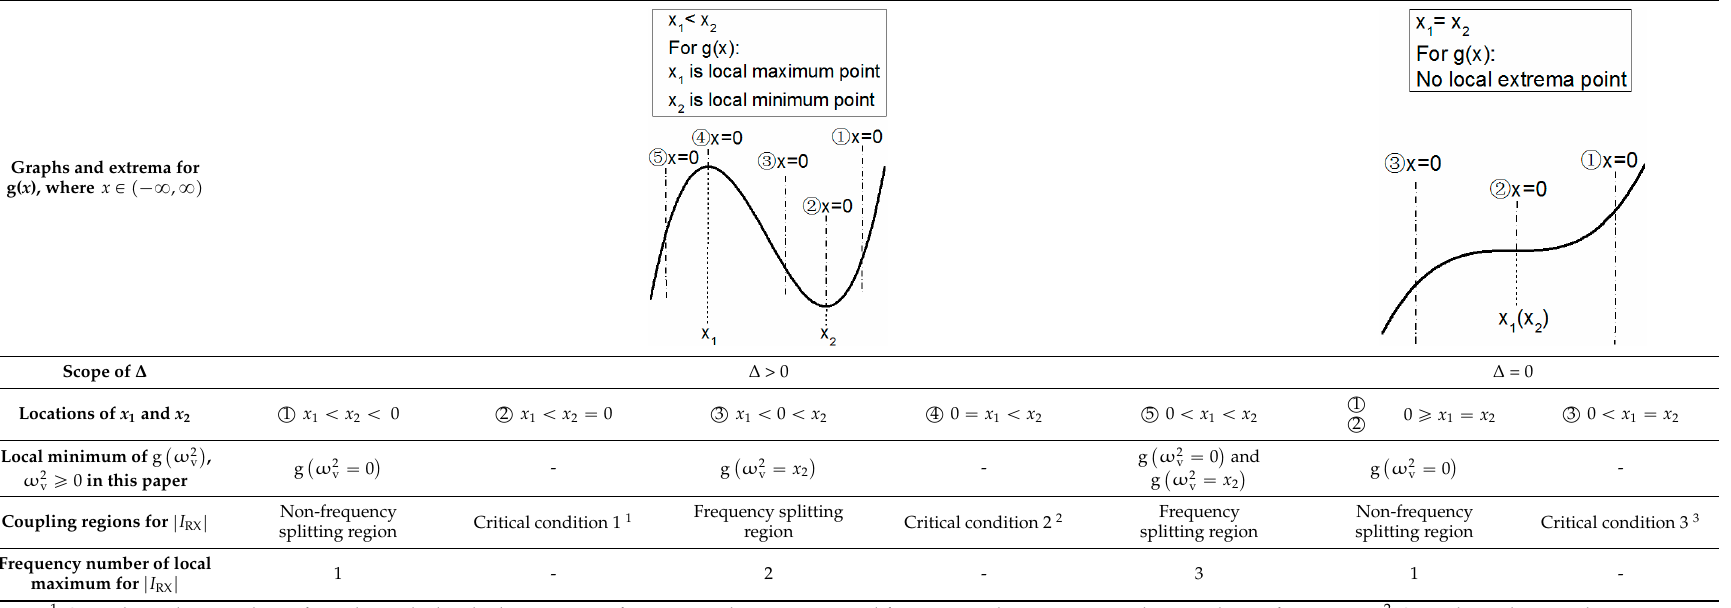
I (or power delivered RX